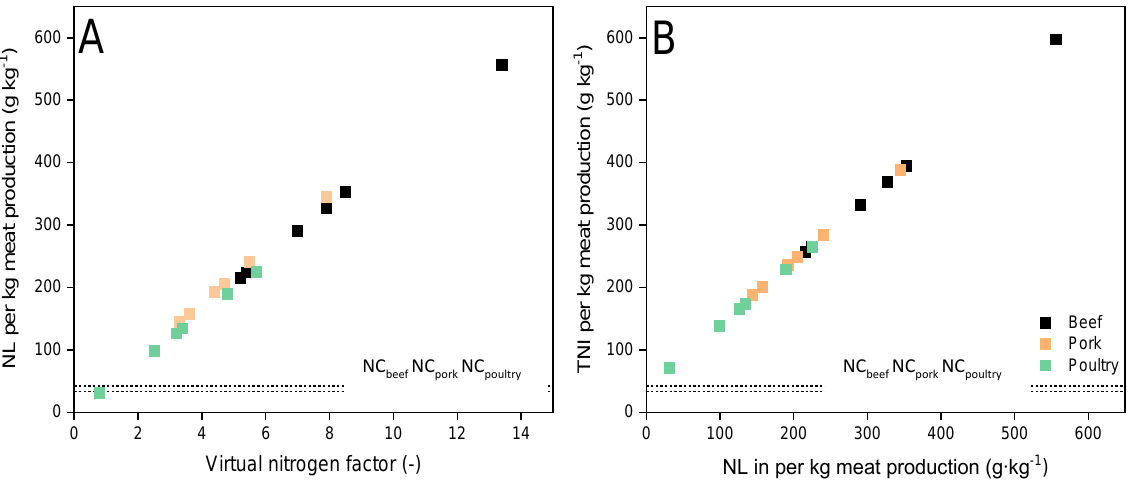
Figure 1. ( A ) Relationship between VNF and NL and ( B ) the corresponding relationship between NL and TNI per kg meat production in different countries. VNF values are given in Table S1.